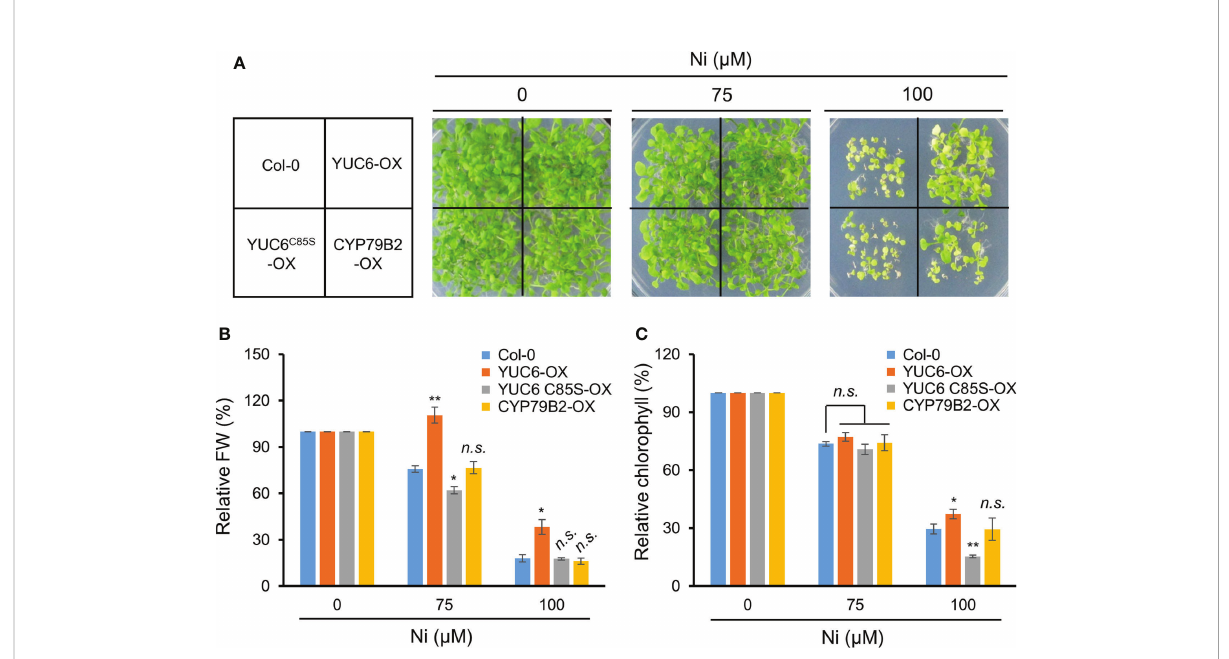
FIGURE 5 TR activity of YUC6 is necessary for YUC6-acquired Ni stress tolerance. Phenotypes (A) , relative fresh weight (B) , and relative chlorophyll contents (C) . Wild-type (Col-0), YUC6-OX, YUC6 C85S -OX, and CYP79B2-OX plants were grown in a half-strength MS medium containing 0, 75, or 100 m M Ni for 2.5 weeks. Values are means ± SE of three independent biological replicates. Asterisks indicate signi fi cant differences (* p < 0.05, ** p < 0.01, and n.s. , no signi fi cant) from the WT at each Ni concentration determined by two-tailed Student ’ s t